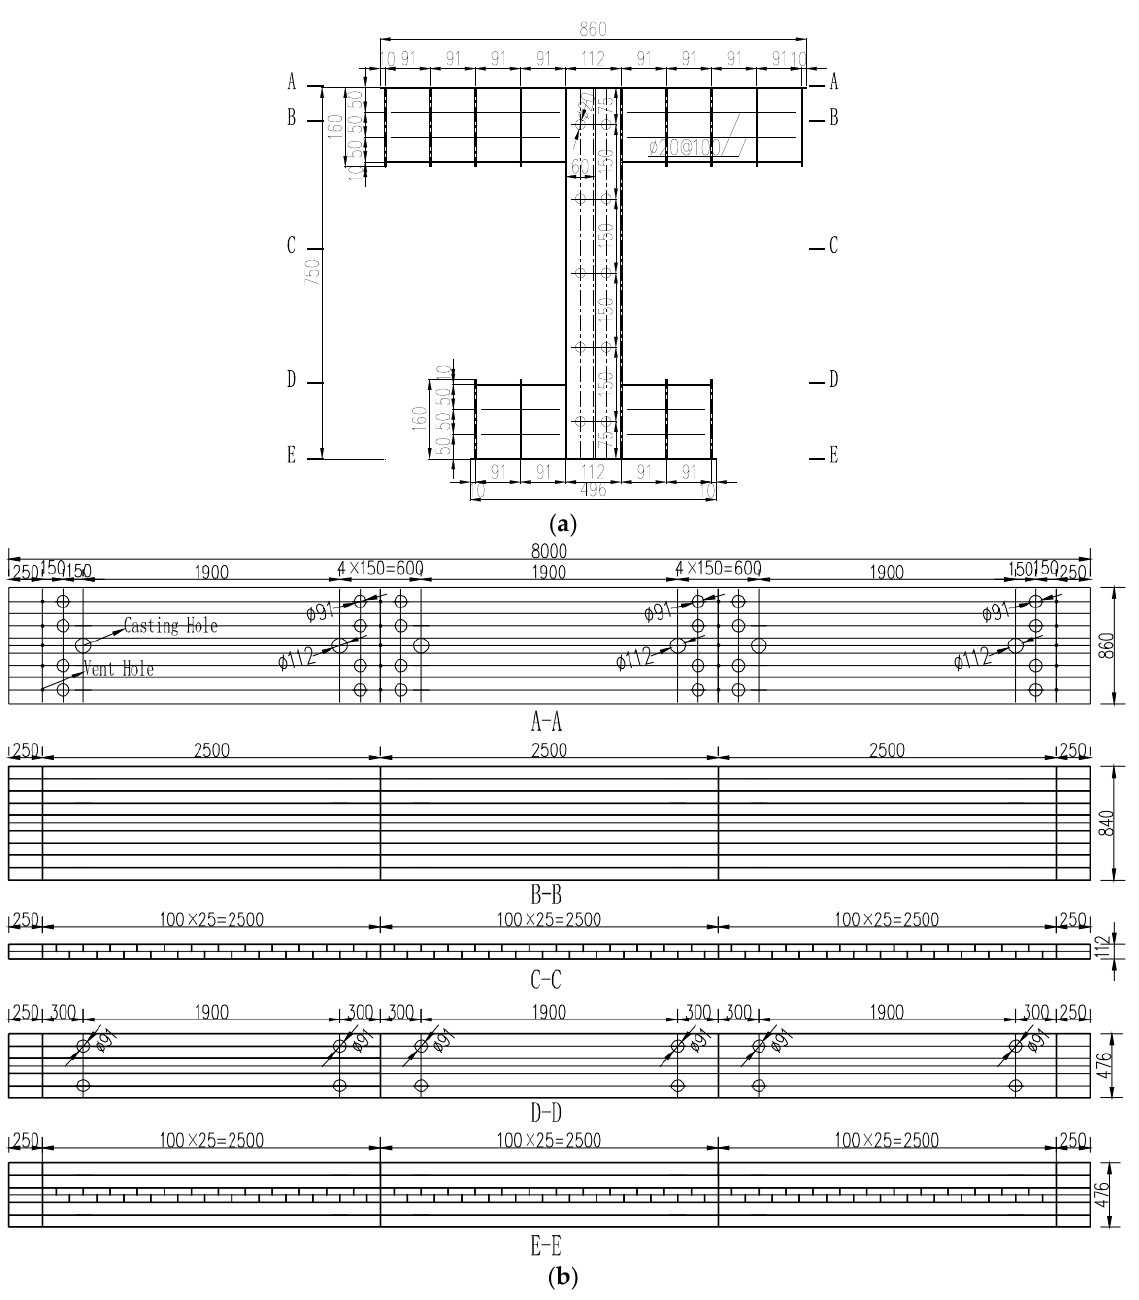
Figure 3. Configuration of the test specimen (mm). ( a ) Composite section and reinforcing bar layout (mm); ( b ) specimen definition.